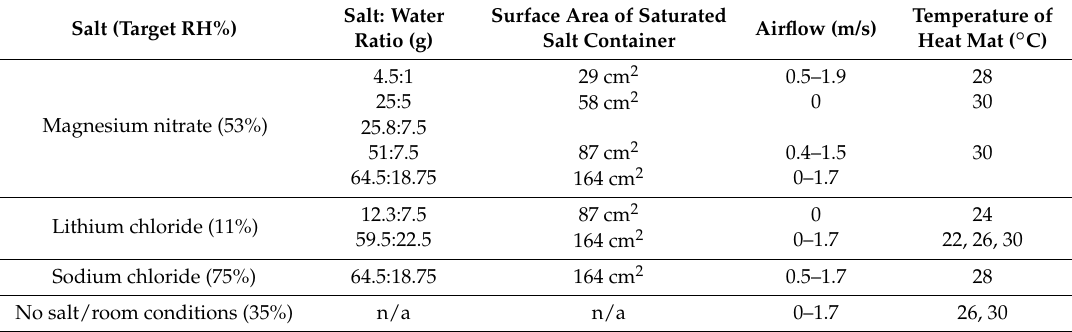
Figure 1. Schematic of test chamber 2 with a cut point of 1 mm above sample plane. All measurements on the outside of the box are in mm. Each area of the chamber is highlighted with a dotted line. Eighteen inoculum droplets can be placed on nonporous surface samples and placed within the test region. Numbers underneath the sample locations indicate airspeed (ms −1 ). Colour overlay represents airflow (ms −1 ), with colours corresponding to the key to the right. Table 1. Experimental and environmental conditions tested in test chamber 2 which were used to generate the linear regression model.